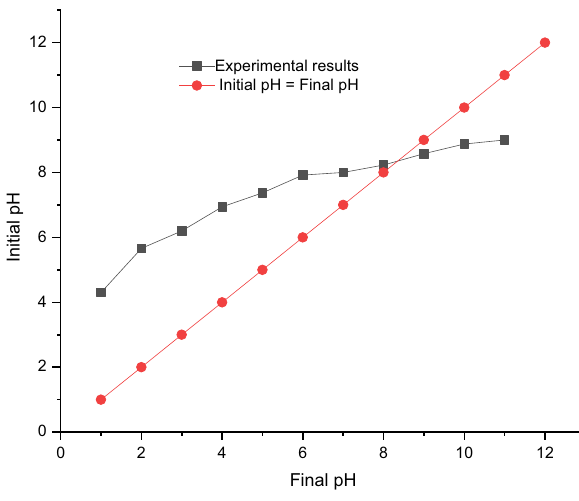
Fig. 6 The level of bacterial contaminants of the analyzed dairy efflu- ents FC: Thermotolerant coliforms; F. Strep: Fecal streptococci; DE: Dairy effluent